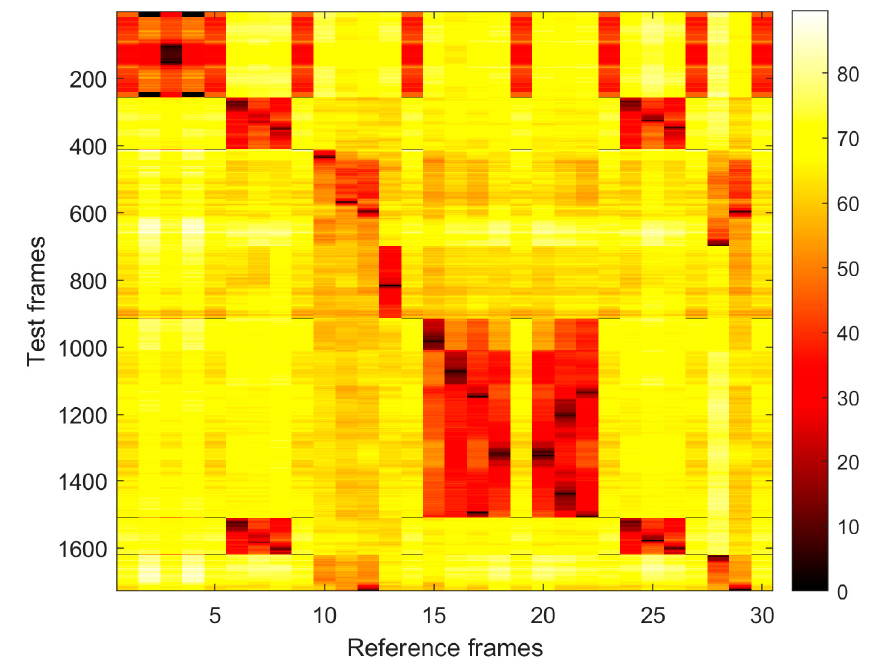
Figure 4. Matching matrix between the reference frames and the test frames using mean absolute error (MAE) as a measure of errors between paired observations. The matrix is used to detect the most similar test frames to the reference frames.